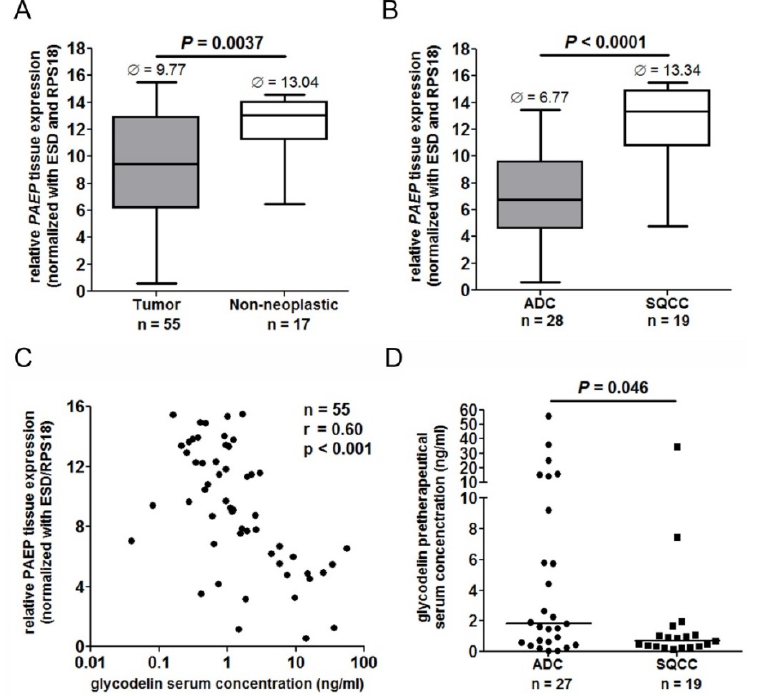
Figure 3. Glycodelin expression in biopsies and serum of advanced stage NSCLC patients. ( A ) Relative PAEP gene expression ( ∆ Ct) in tumor biopsies (( n = 58) estimated tumor cell content ≥ 40%) compared to non-paired tumor-free lung biopsies ( n = 17). Please note that a lower value means a higher gene expression. Ø: median ( B ) Relative PAEP gene expression in ADC and SQCC subhistologies of the cohort. ( C ) Correlation of PAEP expression in biopsies and measured glycodelin serum concentrations of the same patients (no serum available for 3 patients). p < 0.05 was considered as significant. ( D ) Glycodelin serum concentrations of ADC and SQCC patients ( n = 46). PAEP = progesterone-associated endometrial protein, ADC = adenocarcinoma, SQCC = squamous cell carcinoma.